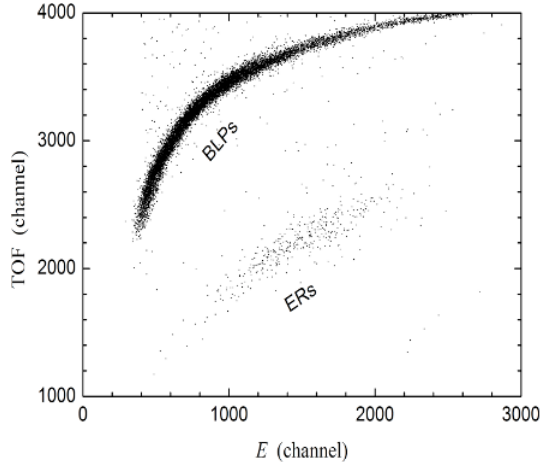
Figure 1. TOF-E matrix measured at the beam energy of 42.08 MeV to identify the BLPs and ERs